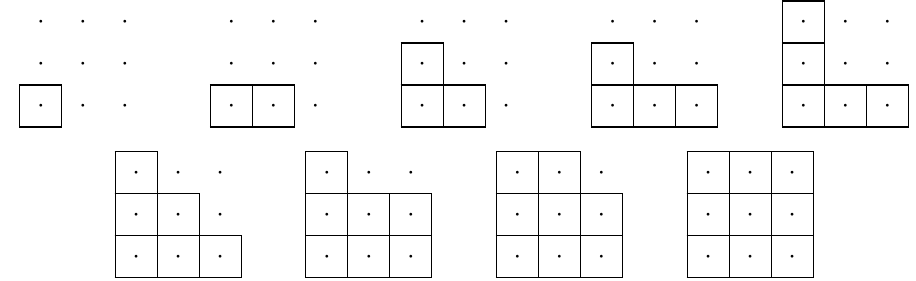
Figure 11. A series of mutations which result in a rotation of the Gr(4 ; 8) initial cluster by one unit. The dots represent unfrozen nodes (arrows have been removed for clarity) and the squares represent the mutated nodes. Note there are no gaps between mutated nodes and we always mutate from the bottom up and from left to right.